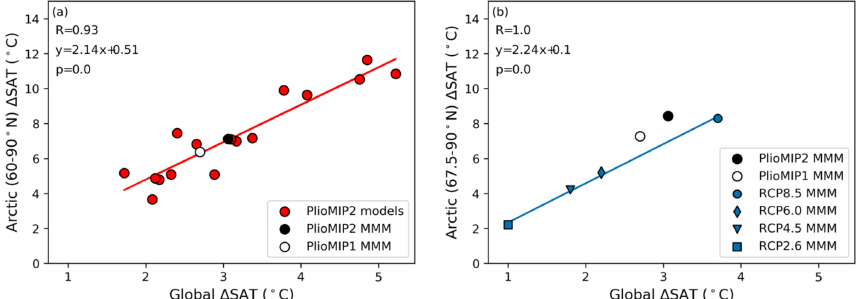
Figure 11. (a) The relationship between global and Arctic (60–90 ◦ N) temperature anomalies in the PlioMIP2 ensemble. The red trend line is constructed based on this relationship for the individual models. (b) The relationship between global and Arctic (here 67.5–90 ◦ N, the definition used by Masson-Delmotte et al. (2013) and the area for which they listed data) for the MMMs of the two PlioMIP and the four CMIP5 future climate ensembles (2081–2100 average). The blue trend line highlights this relationship for the RCP